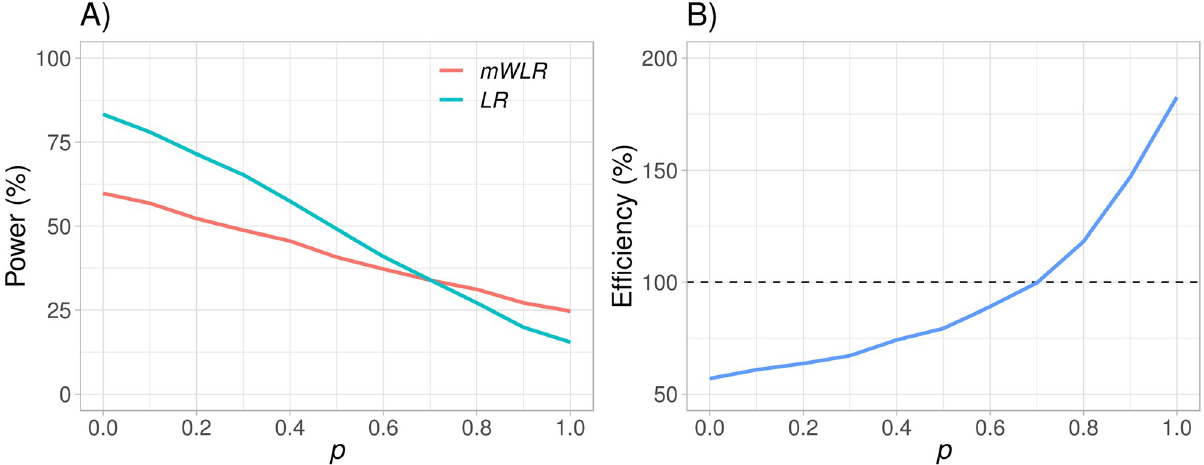
Fig 8. Power of the modified weighted log-rank ( mWLR ) test and the log-rank ( LR ) test (plot A) and efficiency of the mWLR test with respect to the LR test (plot B) assuming a fixed value of m OS ¼ 10 months, a fixed value of p 0 = 1, and varying the value of p between 0 and 1. 0